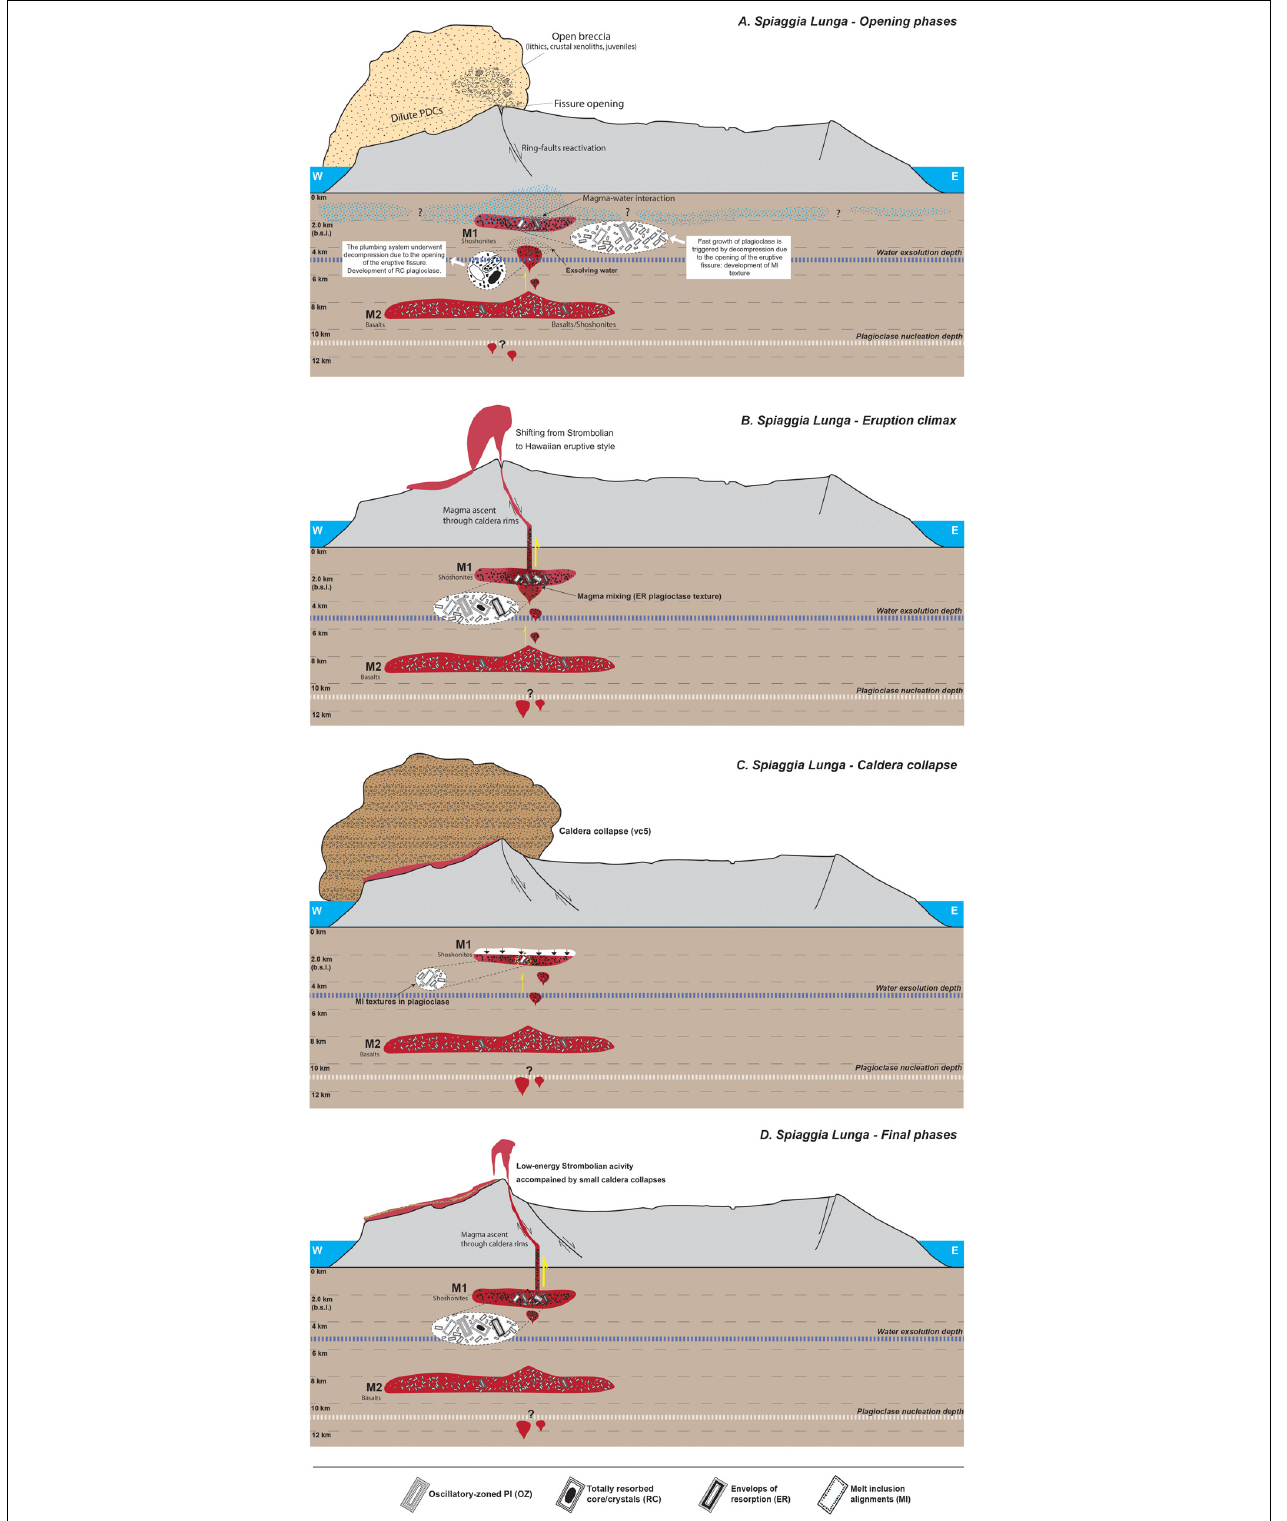
FIGURE 9 | Cartoon showing the different phase of evolution of the Spiaggia Lunga eruption. (A) The SL event starts with an phreatomagmatic eruption, where a shallow residing and zoned magma reservoir with shoshonitic/latitic composition interacts with ground- or sea-water. This causes the deposition of the dilute